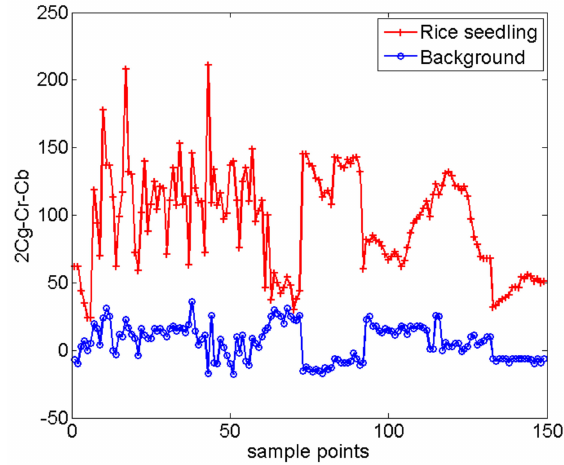
Figure 6. Distribution of 2Cg-Cr-Cb of the rice seedling and background sampling